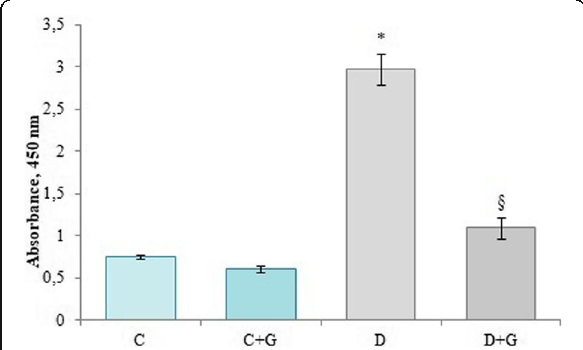
Fig. 2 Effect of Galega officinalis extract on the proliferative activity of bone marrow cells of healthy and diabetic rats. * – P <0.05 compared with controls. # – P <0.05 compared with diabetic rats. § – P <0.05 compared with control and diabetic